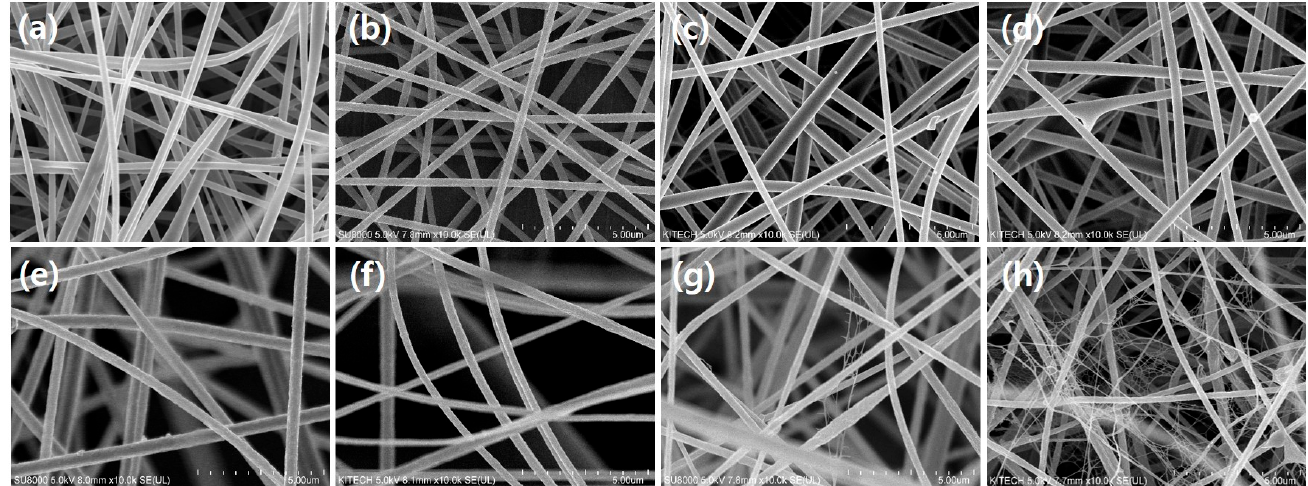
Figure 2. Field-emission scanning electron microscopy (FE-SEM) images of PAN ( a – d ) and PAN–CTAB ( e – h ) nanofiber/(nanonet) web with varying spinning voltage and substrate type: ( a , e ) 15 kV, meltblown (MB), ( b , f ) 15 kV, e-MB, ( c , g ) 40 kV, MB, and ( d , g ) 40 kV, e-MB.